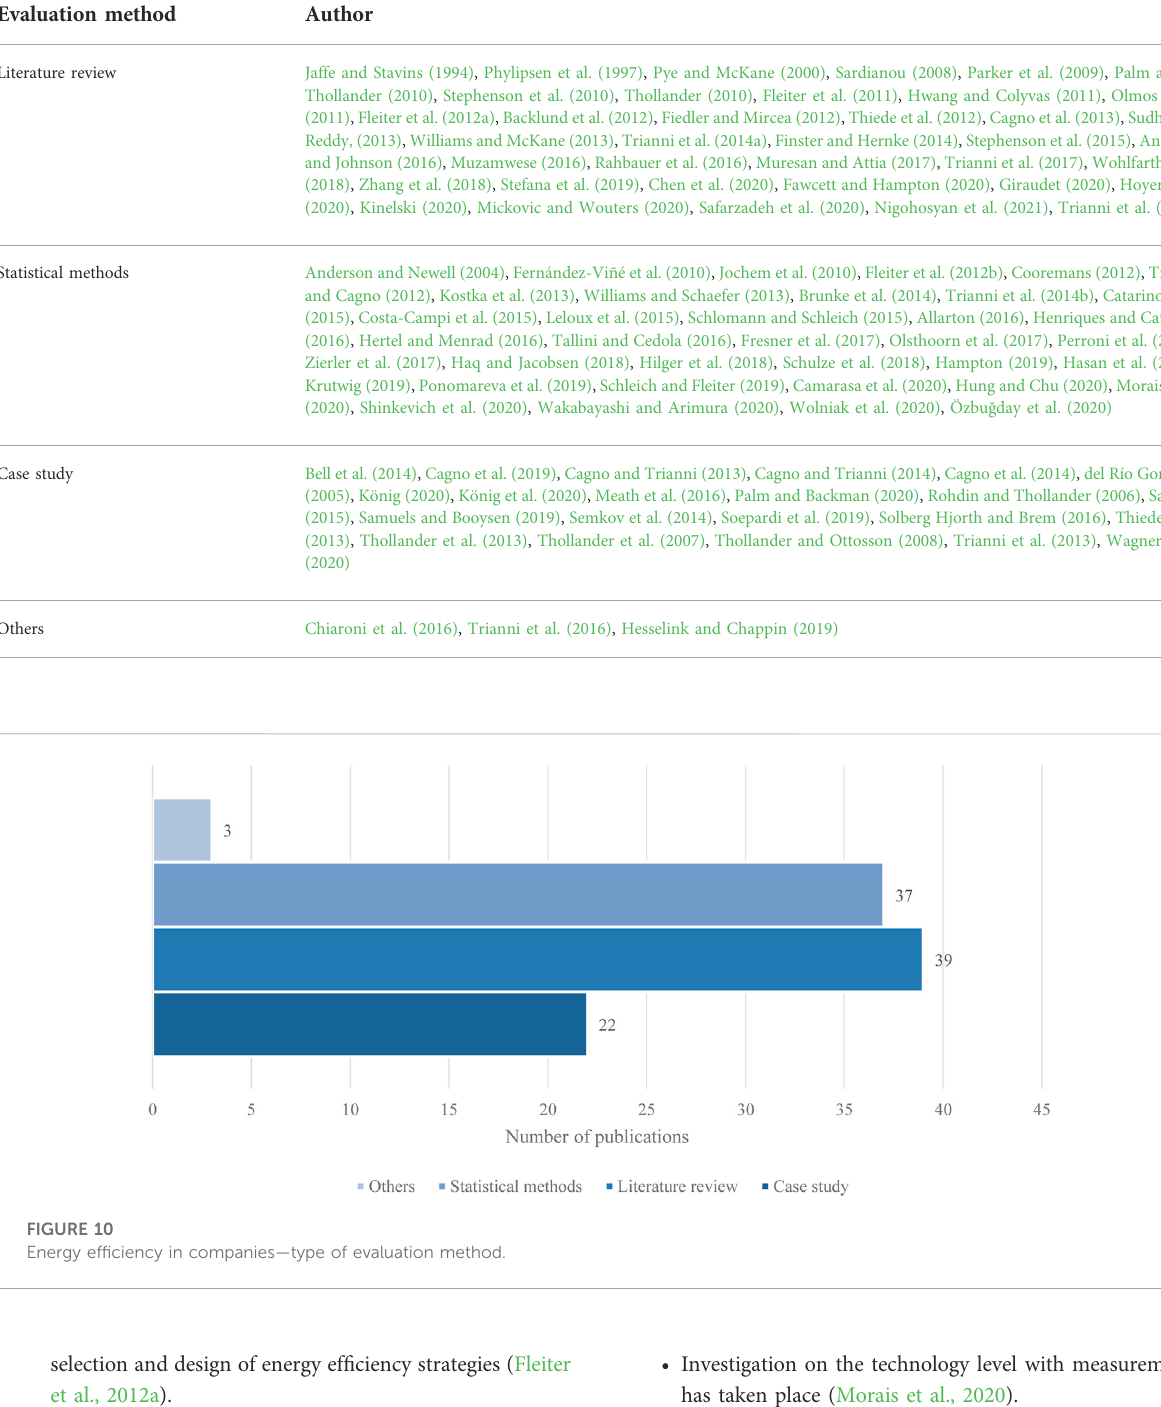
TABLE 6 Classi fi cation of articles by research